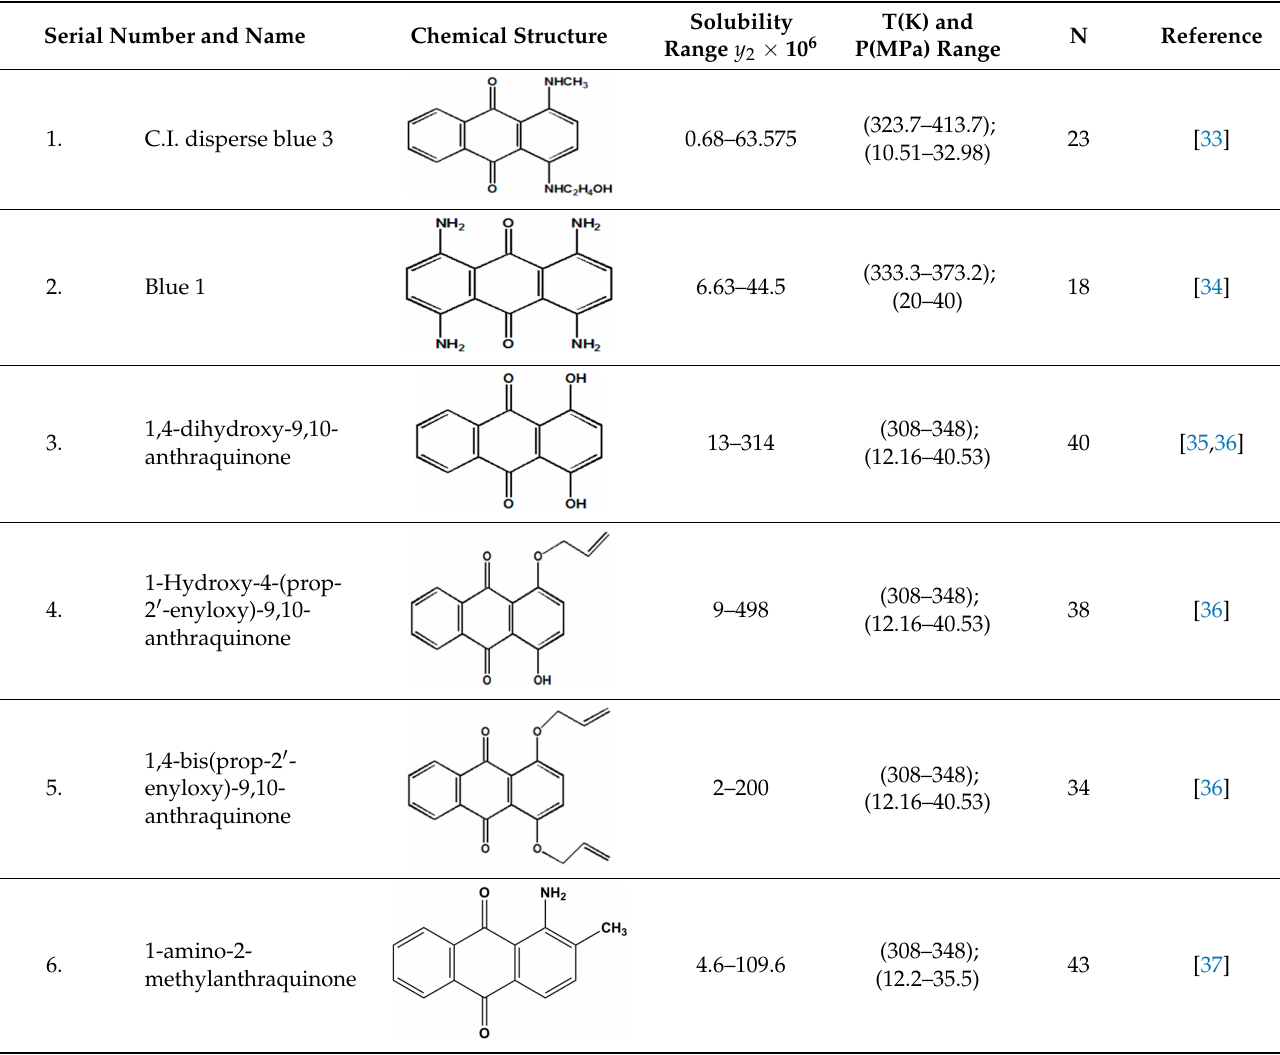
Table 2. Solubility information of the